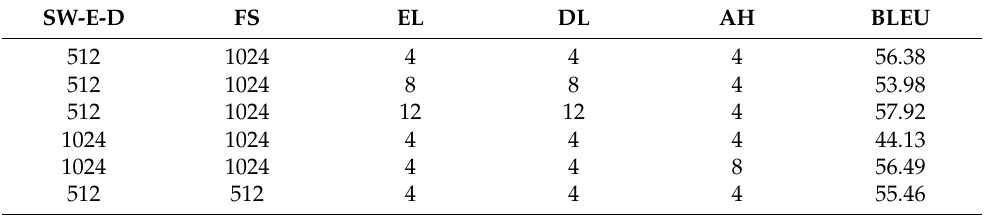
Table 7. Results of the Transformer-Based NMT Subword Model on corpus used by Baniata [22] for LEVANTINE–MSA translation task, where SW-E-D is the Subword embedding dimension, FS is the filter size, EL is the encoder layer, DL is the decoder layer and AH is the attention heads number.